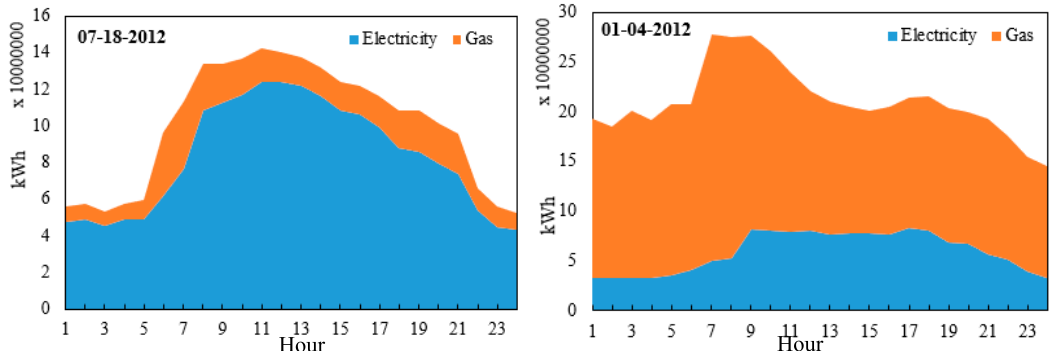
Figure 10. Hourly building energy use for summer and winter peak days.